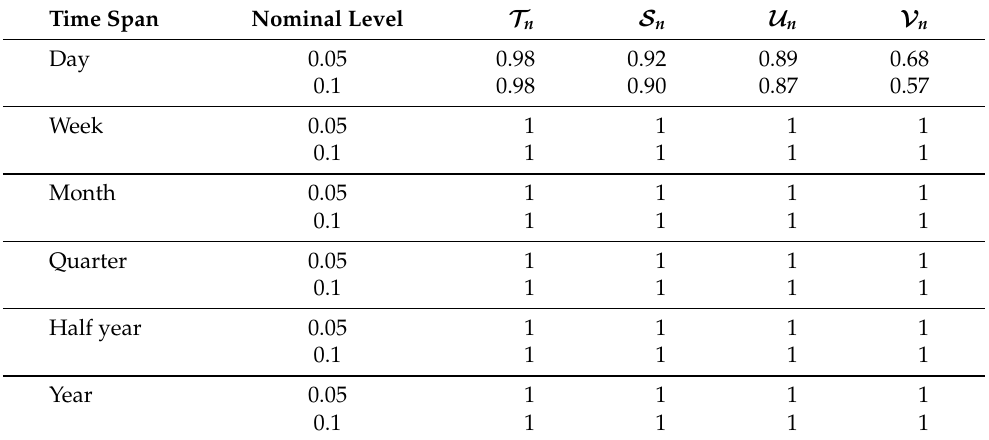
Table 4. Rejection rate of